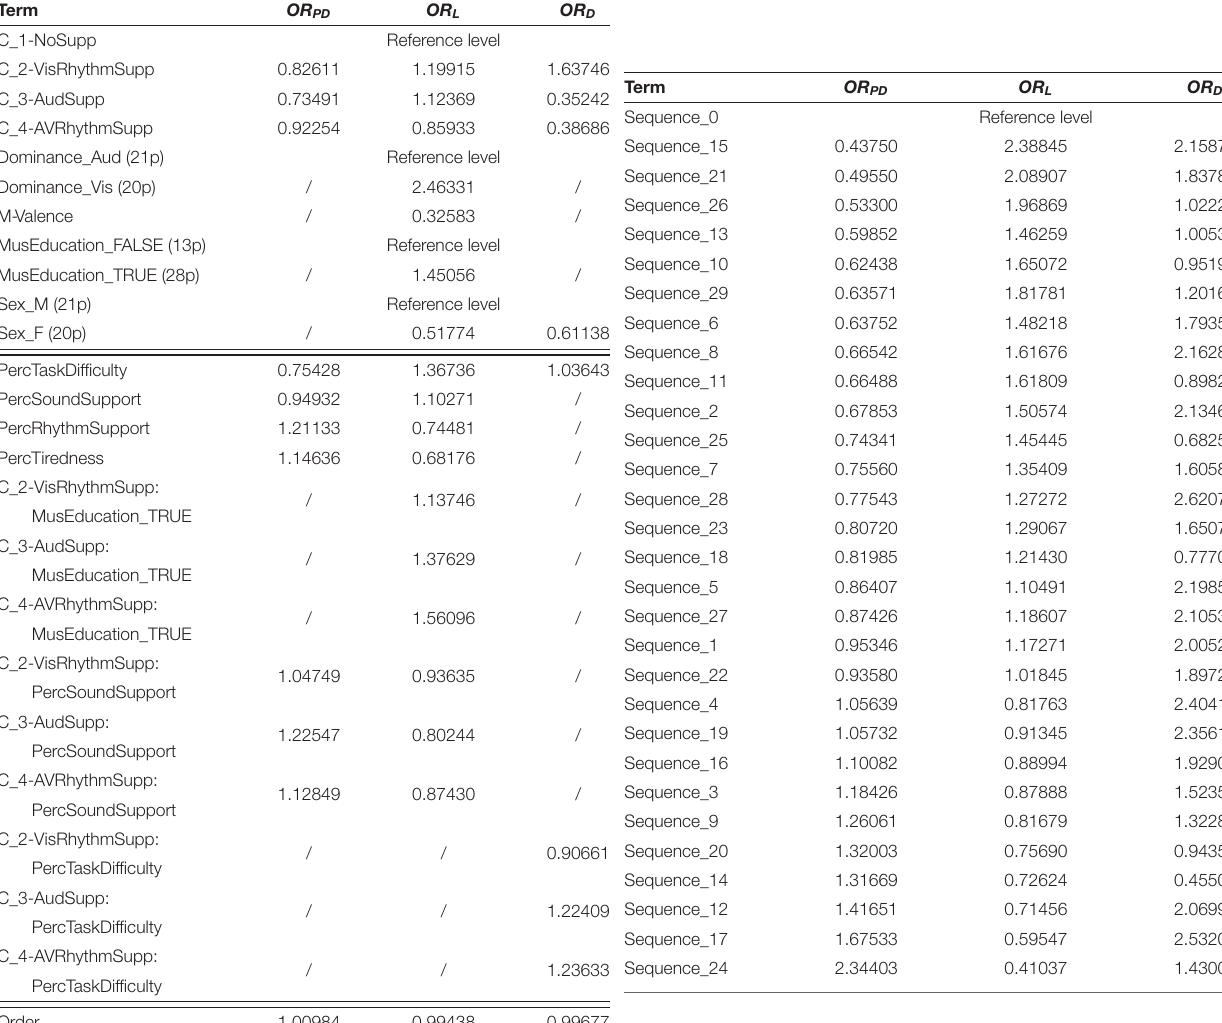
TABLE 2 | Odds ratios (OR) of all terms in the final model for all three outcome scores; OR are given per unit increase of the independent variable.